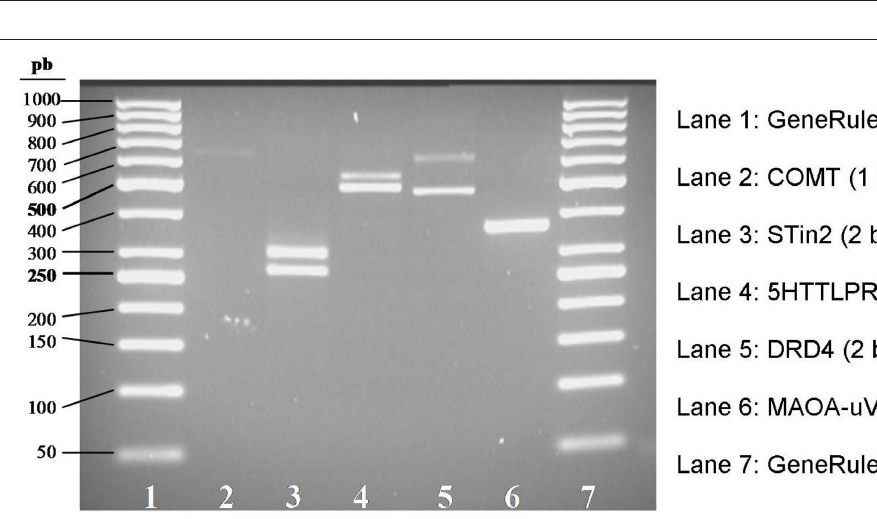
FIguRe 2 | Region of the left superior frontal gyrus showing reduced gray matter density in J.F. relative to healthy controls, at p < 0.05 (corrected for multiple comparisons).